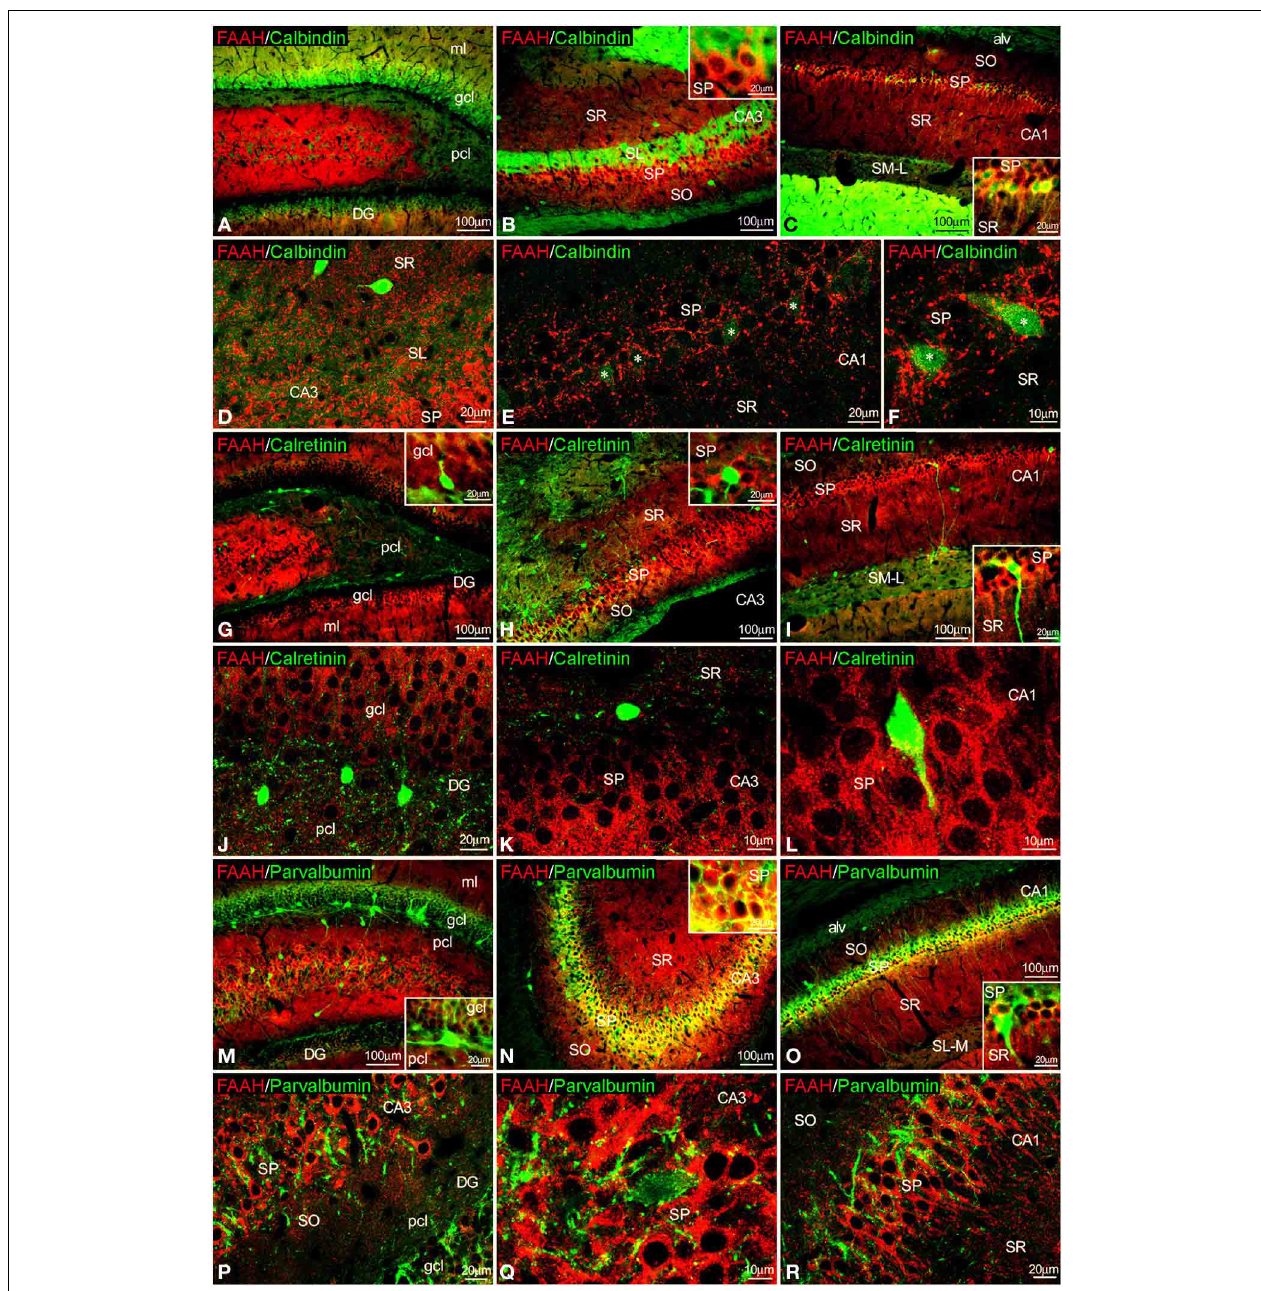
FIGURE 6 | Co-localization of FAAH and calbindin, calretinin or parvalbumin in the rat hippocampus. Low resolution epifluorescence photomicrographs (A–C,G–I,M–O) and high resolution confocal laser scanning photomicrographs (D–F,J–L,P–R) showing labeling for calbindin,